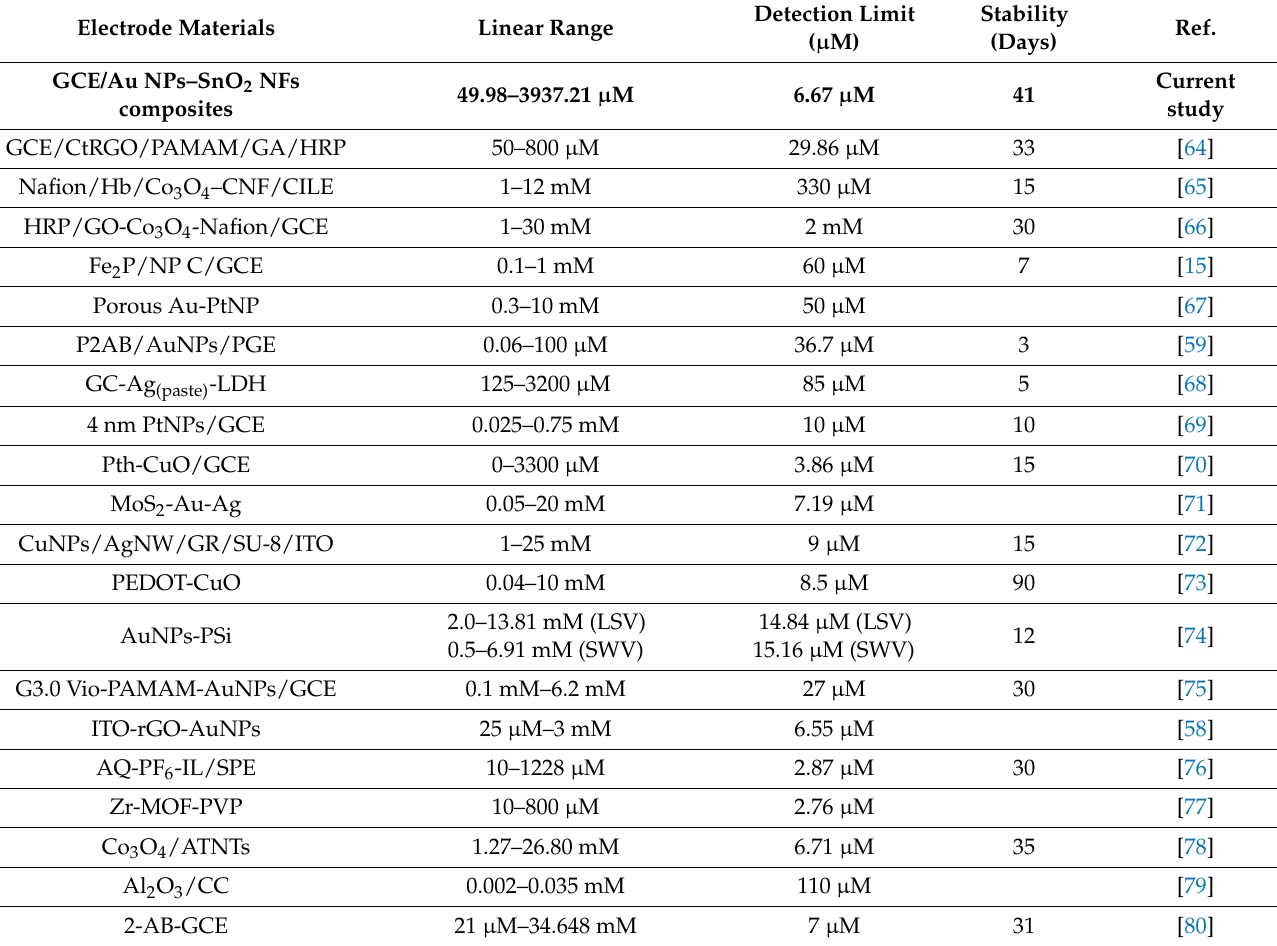
Table 1. Sensor performance